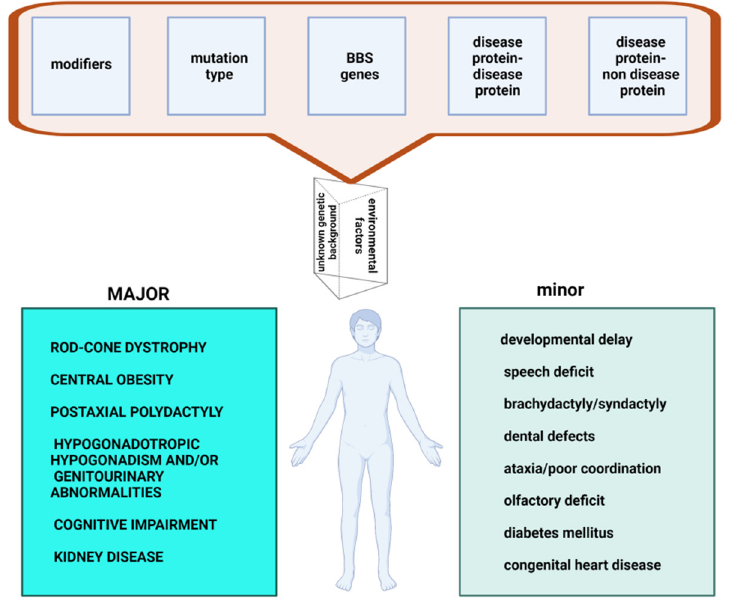
Figure 1. Heterogeneity in Bardet Biedl Syndrome-determinants and clinical effects. Created with BioRender.com (accessed on 15 August 2021).